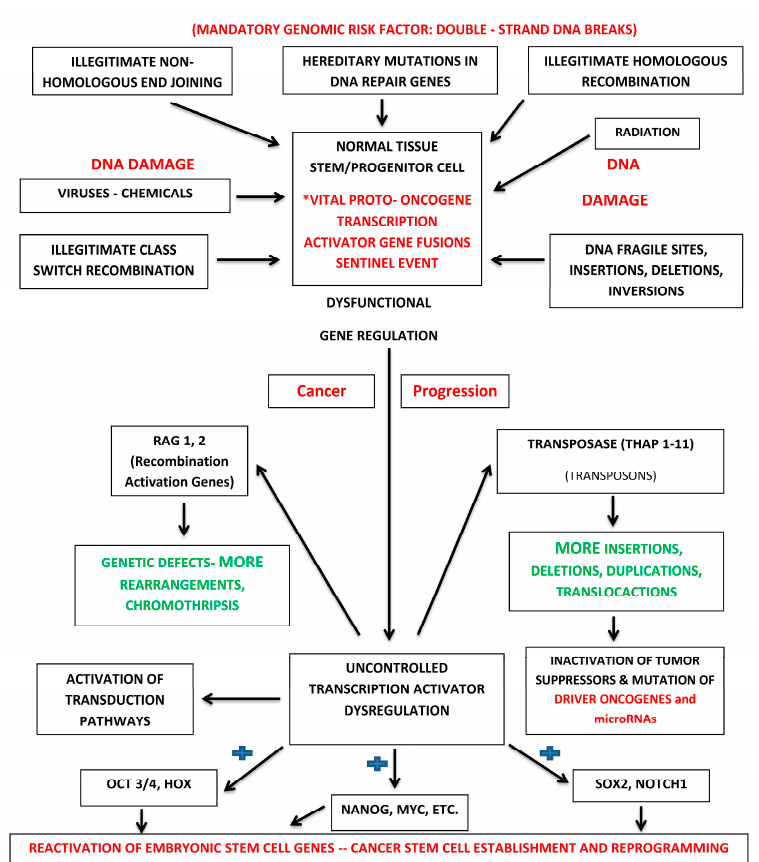
Figure 1. Holistic molecular genetic paradigm for cancer initiation and progression. *The sentinel event in cancer occurs when a double-strand break is introduced into DNA at the site of a proto-oncogene transcription activator within a normal tissue stem or progenitor cell resulting in the subsequent production of a chimeric oncogenic protein with novel gene regulatory properties. The blue shape (+): vital oncogenes constitutively activate stem cell maintenance genes such as OCT3/4 , HOX , NANOG , MYC , SOX2 and NOTCH1.